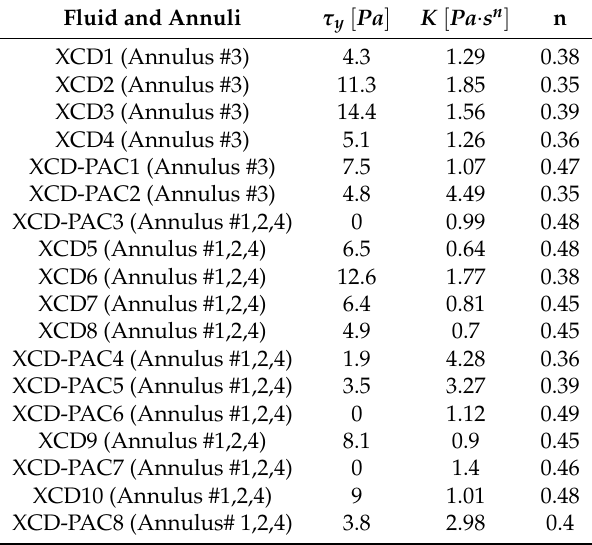
Table A1. Details of the